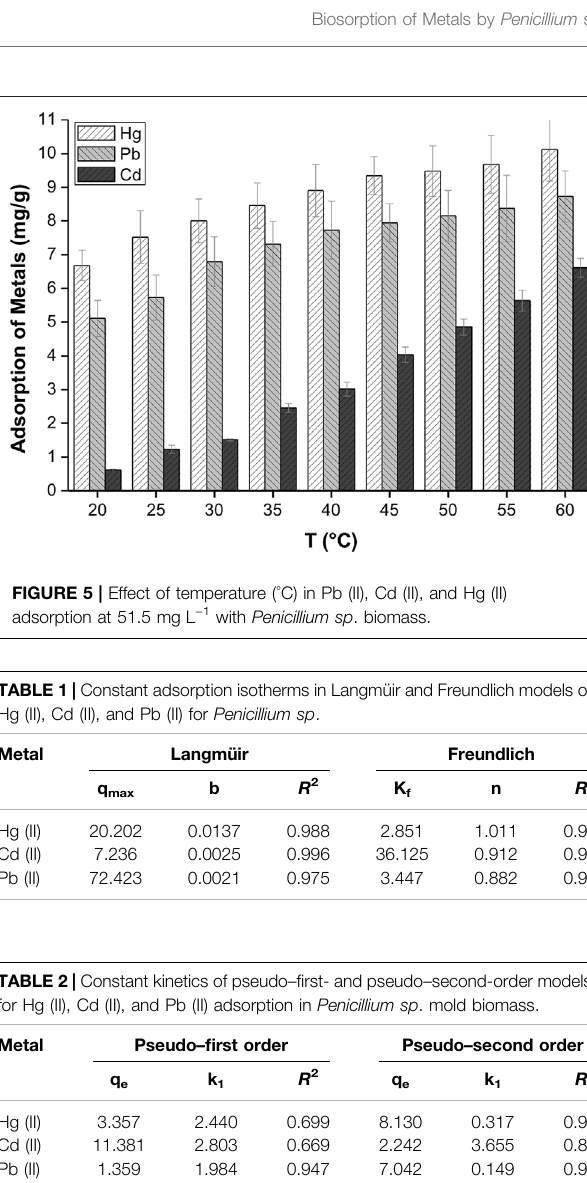
FIGURE 4 | Effect of the amount of biomass (g) in Pb (II), Cd (II), and Hg (II) adsorption at 51.5 mg L − 1 with Penicillium sp . biomass.